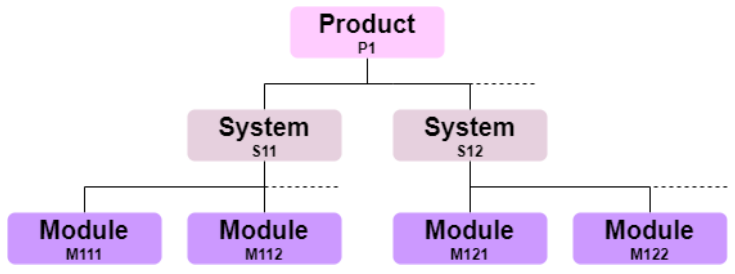
Figure 5. General modular breakdown